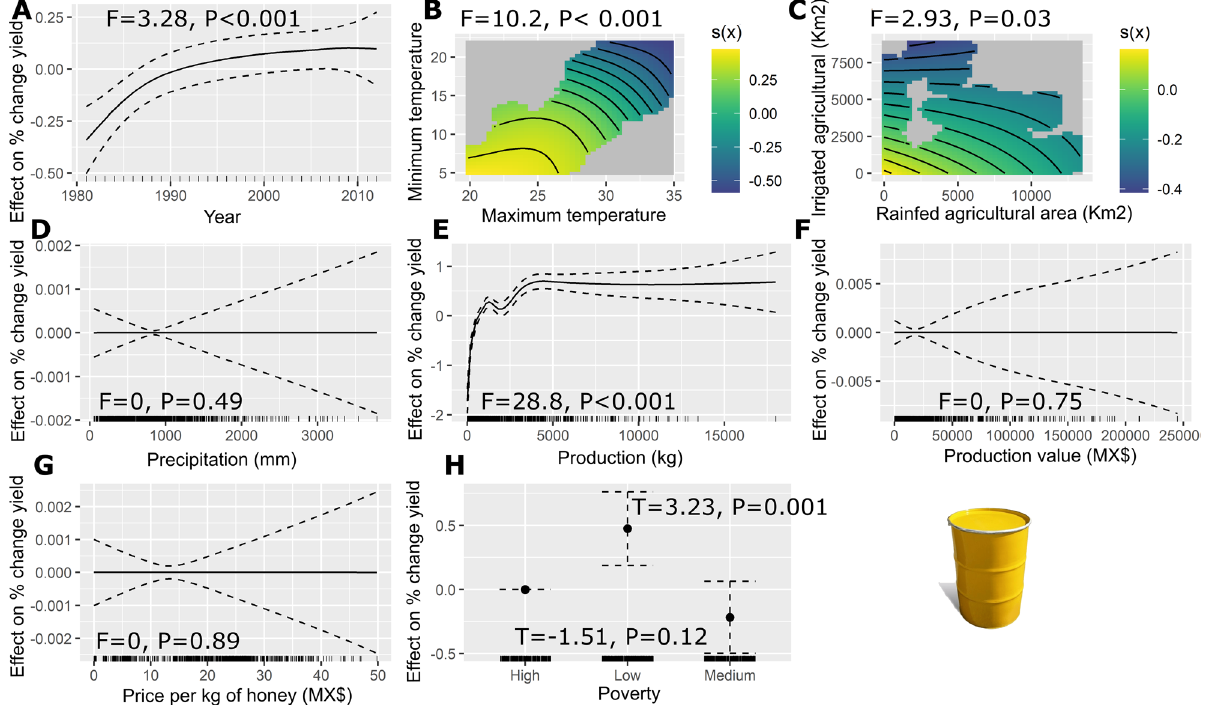
Figure 2. Estimated smoothness of; ( a ) year, ( b ) non-linear interaction between minimum temperature and maximum temperature, ( c ) non-linear interaction between land use categories, ( d ) precipitation (mm), ( e ) production of honey (kg), ( f ) Production value (MX$), ( g ) price per kg of honey, and ( h ) Poverty over the percent change in yield; y-axis is the partial effect of the variable and the shaded area represents 95% of the confidence interval around the main effect.